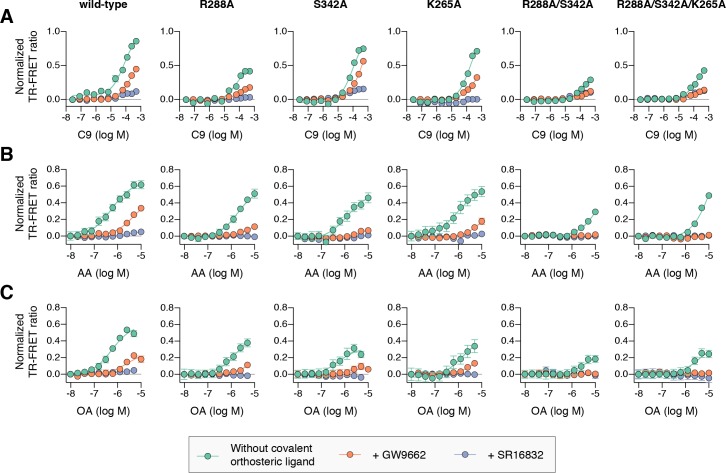
Effect of ligand cobinding of a covalent orthosteric synthetic ligand with MCFA or UFA ligands on PPARγ-coactivator recruitment.TR-FRET biochemical assays showing concentration-dependent changes in the recruitment of a peptide derived from the TRAP220 coactivator for (A) C9, (B) AA, and (C) OA. Experiments were performed in the absence or presence of a covalent orthosteric synthetic ligand; and for wild-type PPARγ LBD or mutant variants; as indicated. Data plotted as the average and S.E.M. of three experimental replicates. Also see
Figure 10—figure supplements 1–4.